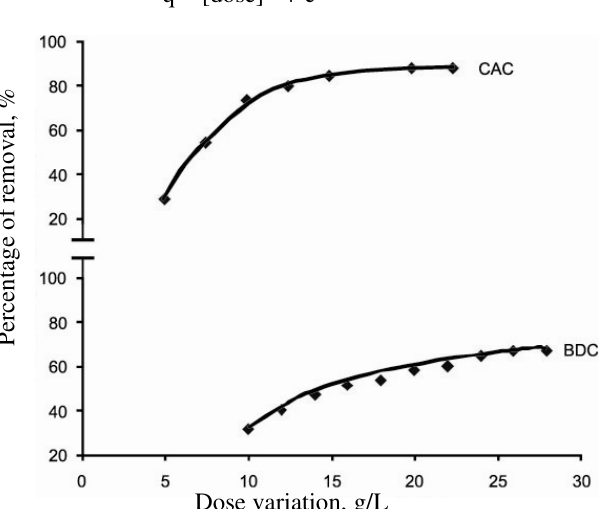
Figure 3. Effect of dose variation on the removal of lead(II) ions by BDC and